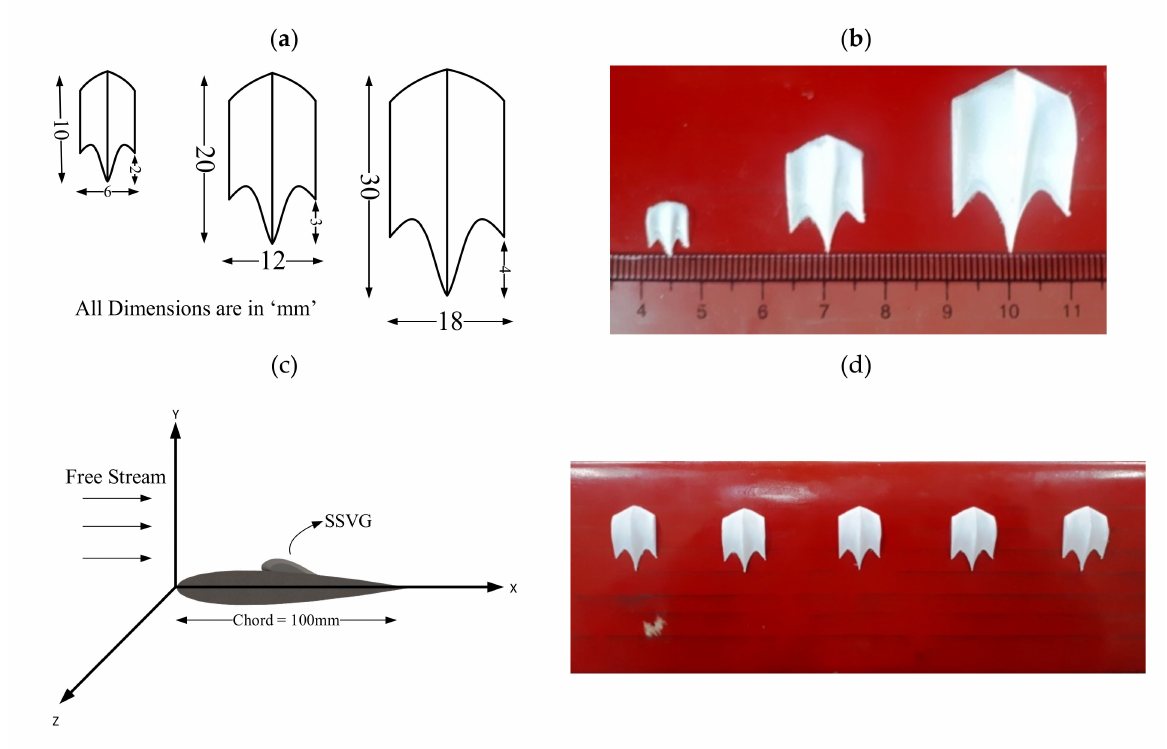
Figure 4. Shark scale vortex generator (SSVG): ( a ) Individual Shark Scale Vortex generator (SSVG) models, ( b ) 3D Printed SSVG models, ( c ) Schematic representation of the SSVG blended over the test airfoil, and ( d ) A typical view of the SSVG blended over the test